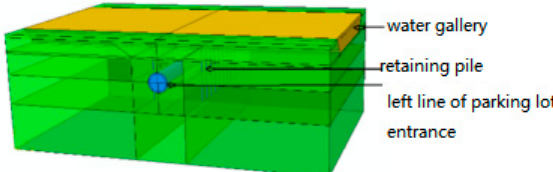
Figure 6. Overall diagram of the left tunnel and the water gallery model.